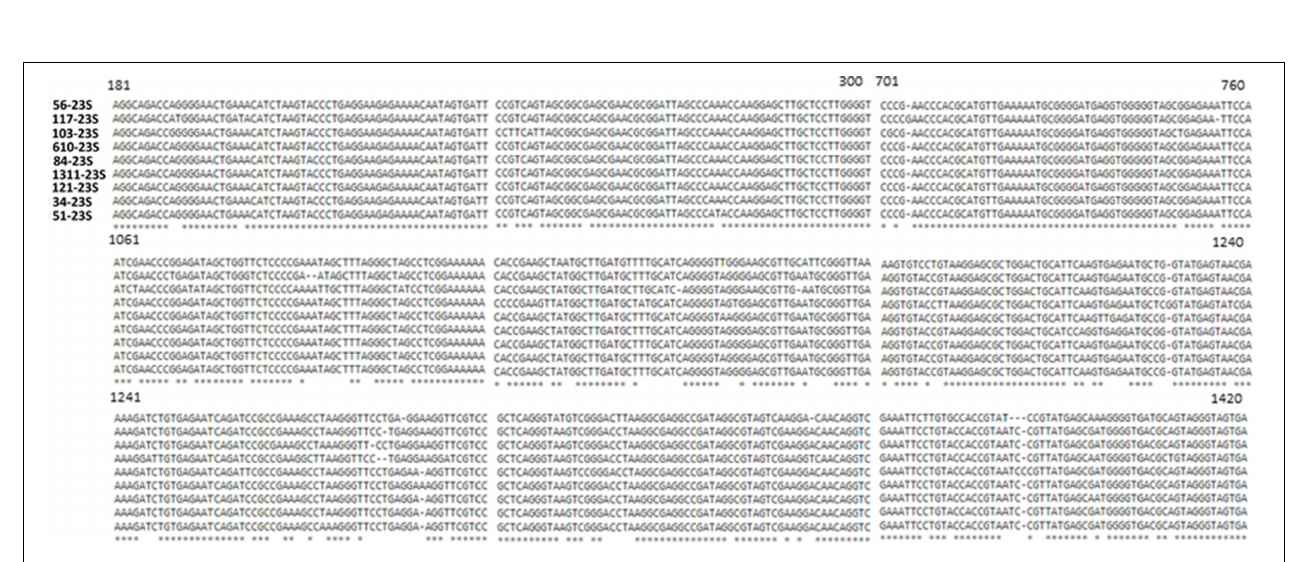
FIGURE 9 | Clustal (cid:2) alignment of 23S ribosomal subunit regions from CR1 genome. Numbers to the left of sequence data represent the specific contig gap where the ribosomal subunit DNA was located. Numbers above